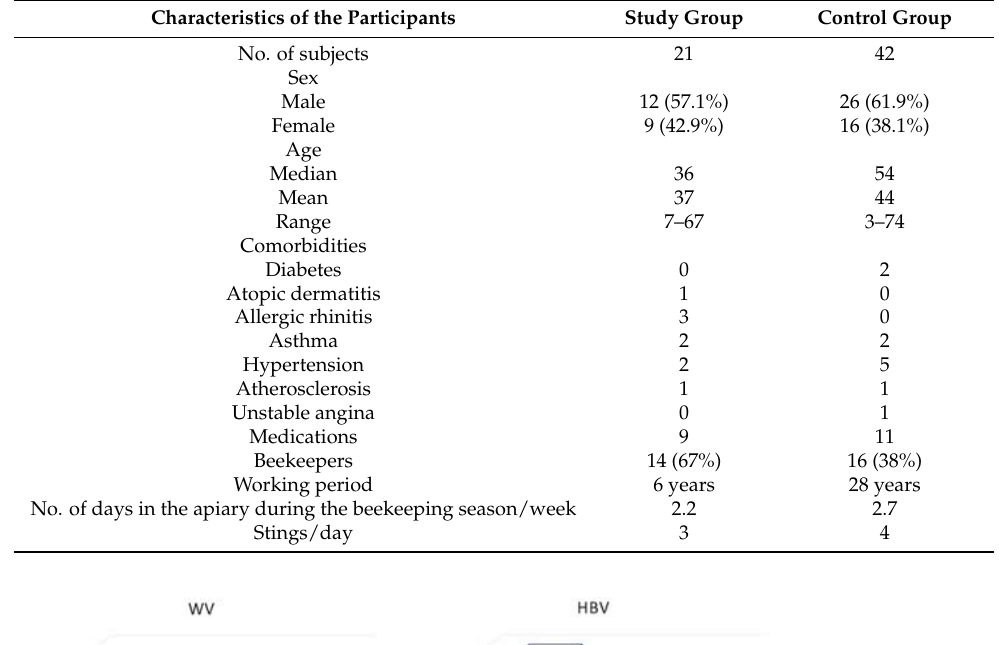
Table 1. Characteristics of patients allergic to Hymenoptera venom (study group) and healthy individ- uals (control group).